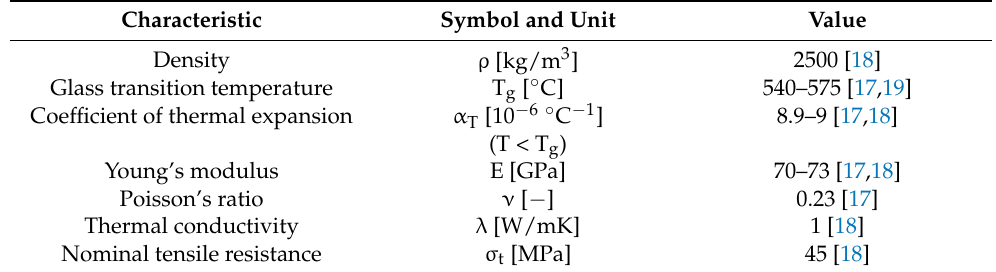
Table 1. Some thermal and mechanical characteristics of annealed soda–lime–silica glass [17–19].